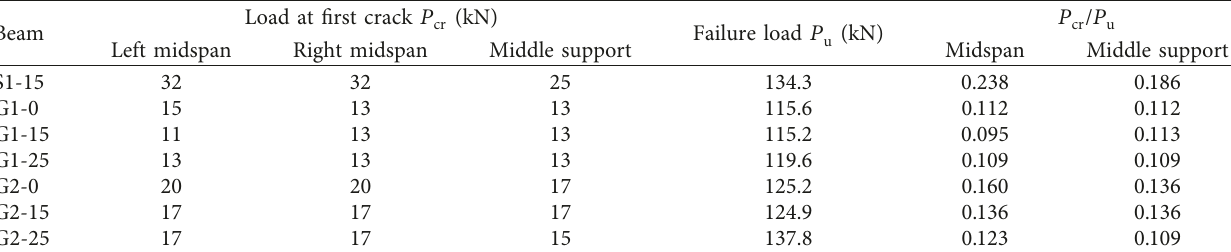
Figure 5: Failure modes of tested beams. (a) S1-15. (b) G1-0. (c) G1-15. (d) G1-25. (e) G2-0. (f) G2-15. (g) G2-25. Table 3: First crack loads and failure